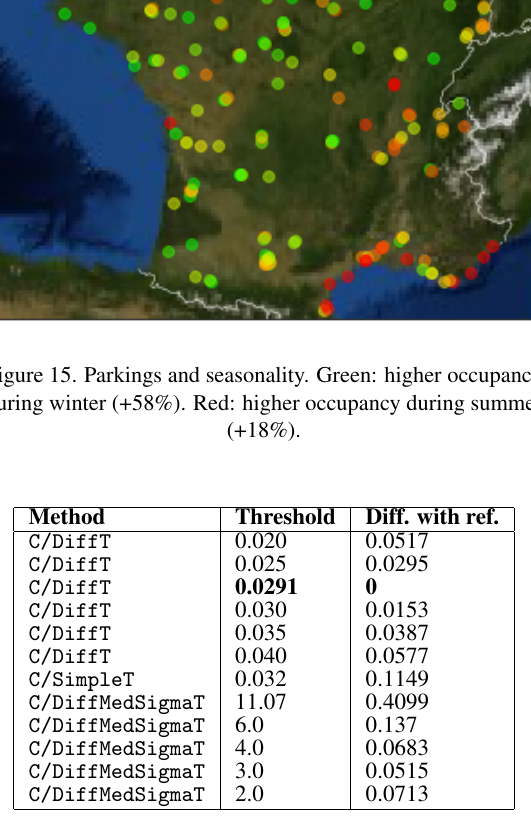
Figure 13. Aggregated occupancy ratio R agg between 2018-01-01 and 2019-12-31, estimated with the C/DiffT method, adjusted for weekly patterns and summer time.